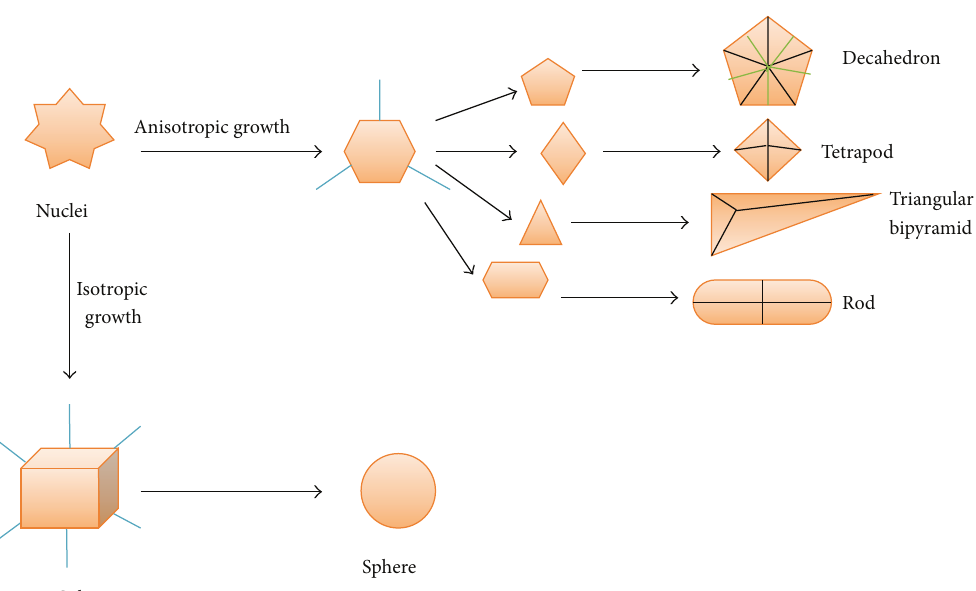
Figure 3: Growth of nanoparticles by different ways and their resulting geometrical